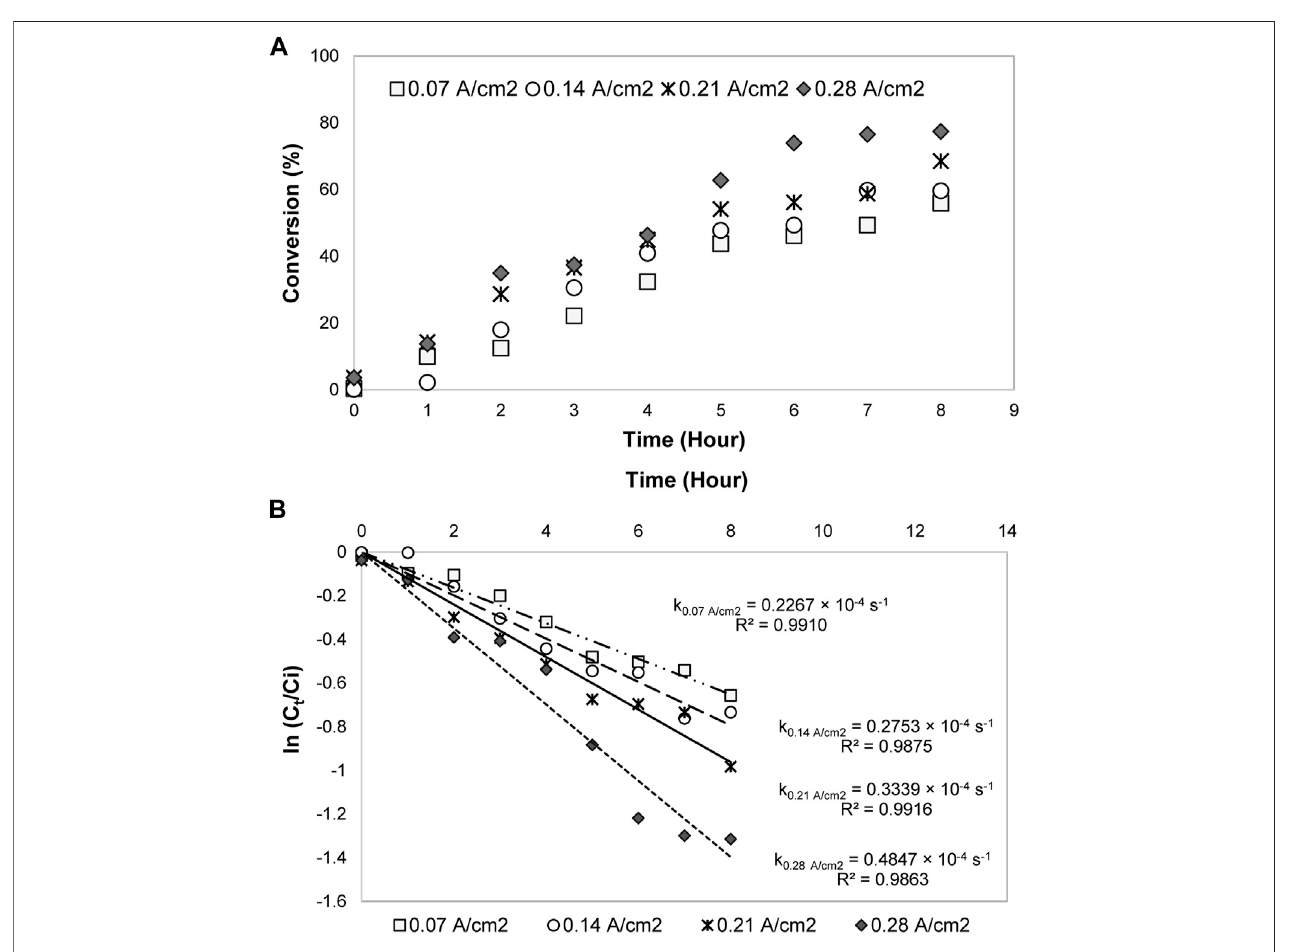
FIGURE 9 | (A) Glycerol conversion (%) and (B) fi rst-order kinetics model for glycerol electrocatalytic reduction at different current densities.